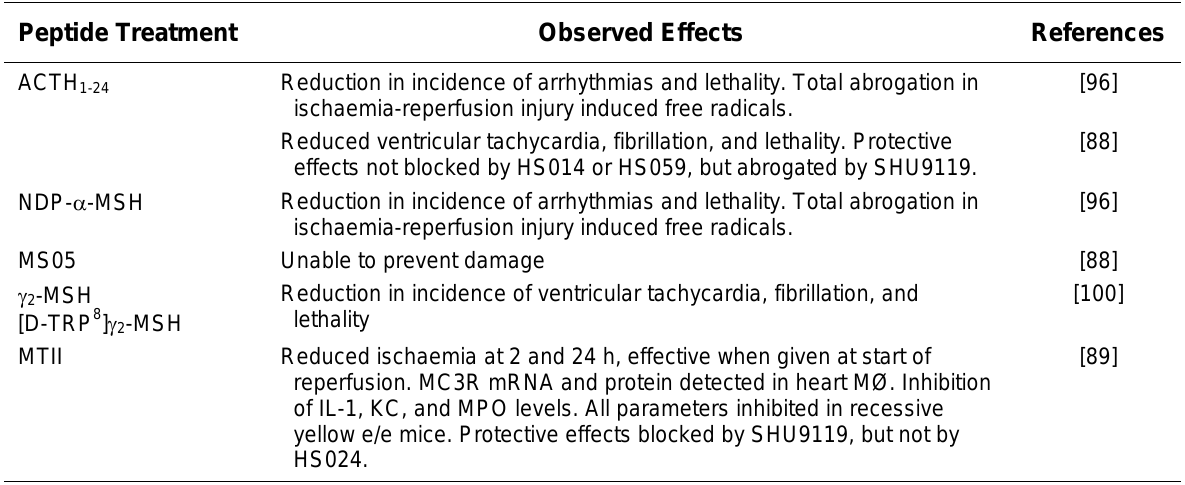
Melanocortin Peptides Effects in Myocardial-Reperfusion Injury Peptide Treatment Observed